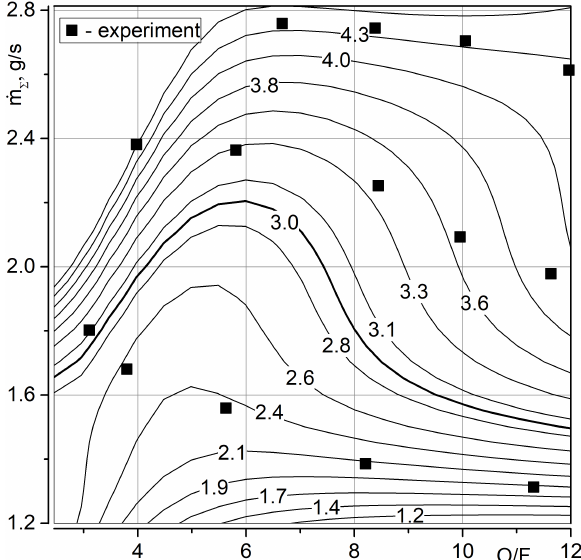
Figure 5. Average power in kW absorbed by the fuel grain: contour lines are approximations of the experimental